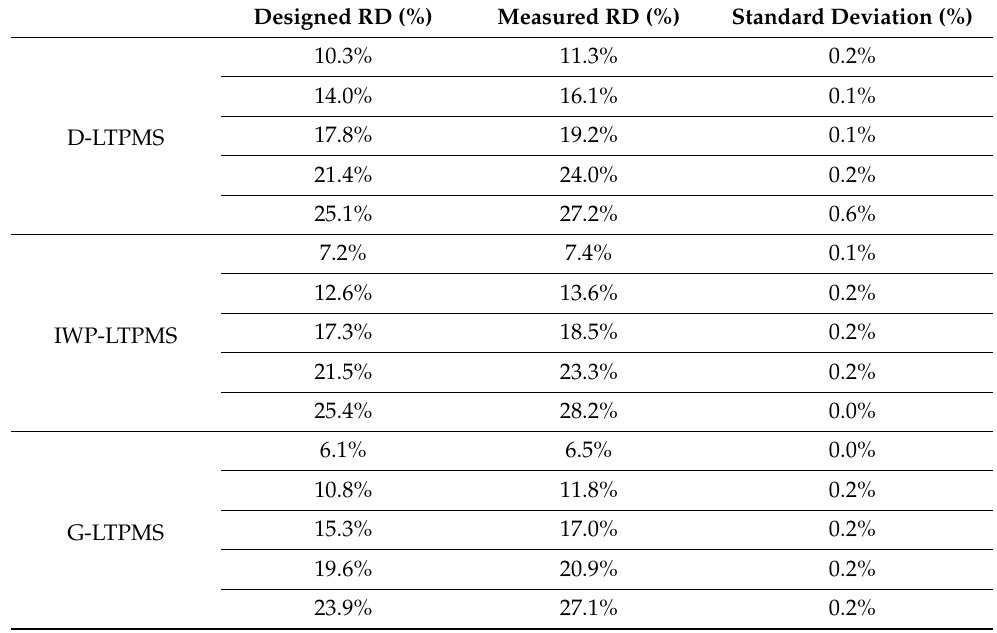
Table 4. Designed versus measured RD for the ligament-based and sheet-based TPMS